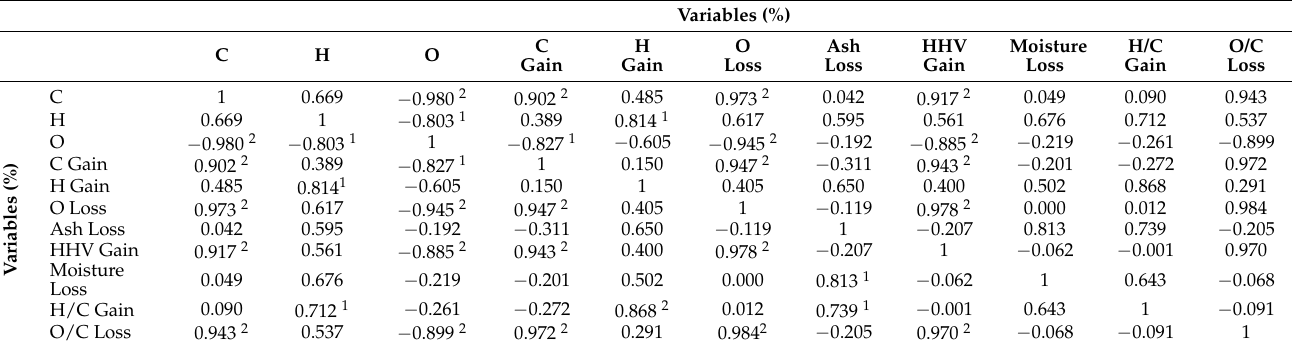
Table 4. Pearson’s correlation (r) from elemental analysis and bio-oil variables. Variables